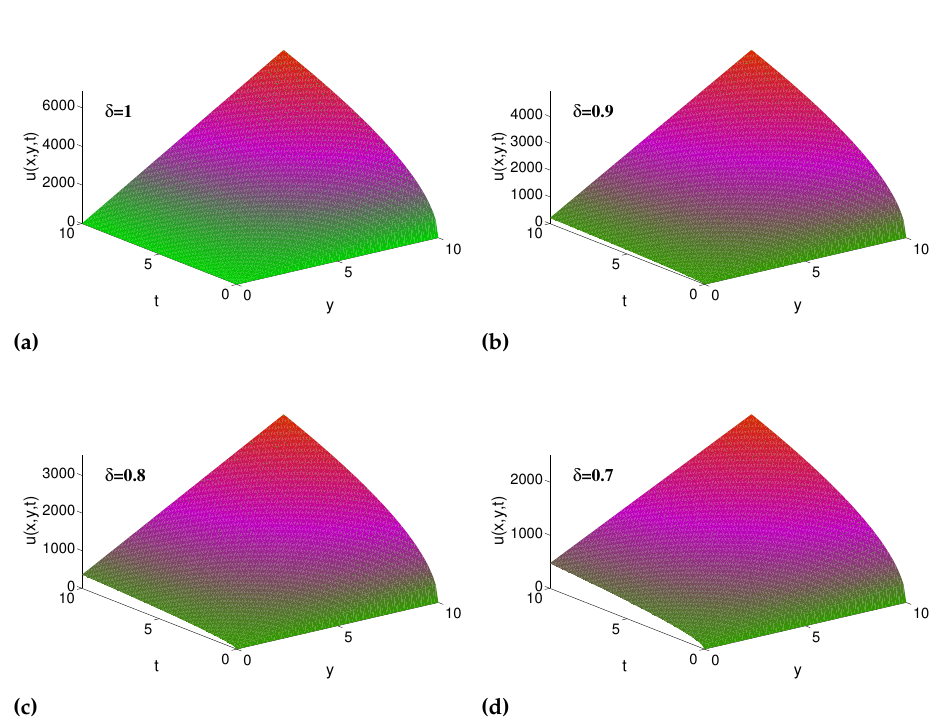
Figure 3. The numerical simulations of Equation (10) with ( a ) δ = 1, k = 3 ( b ) δ = 0.9, k = 3 ( c ) δ = 0.8, k = 3 ( d ) δ = 0.7, k = 3 and x = 3.